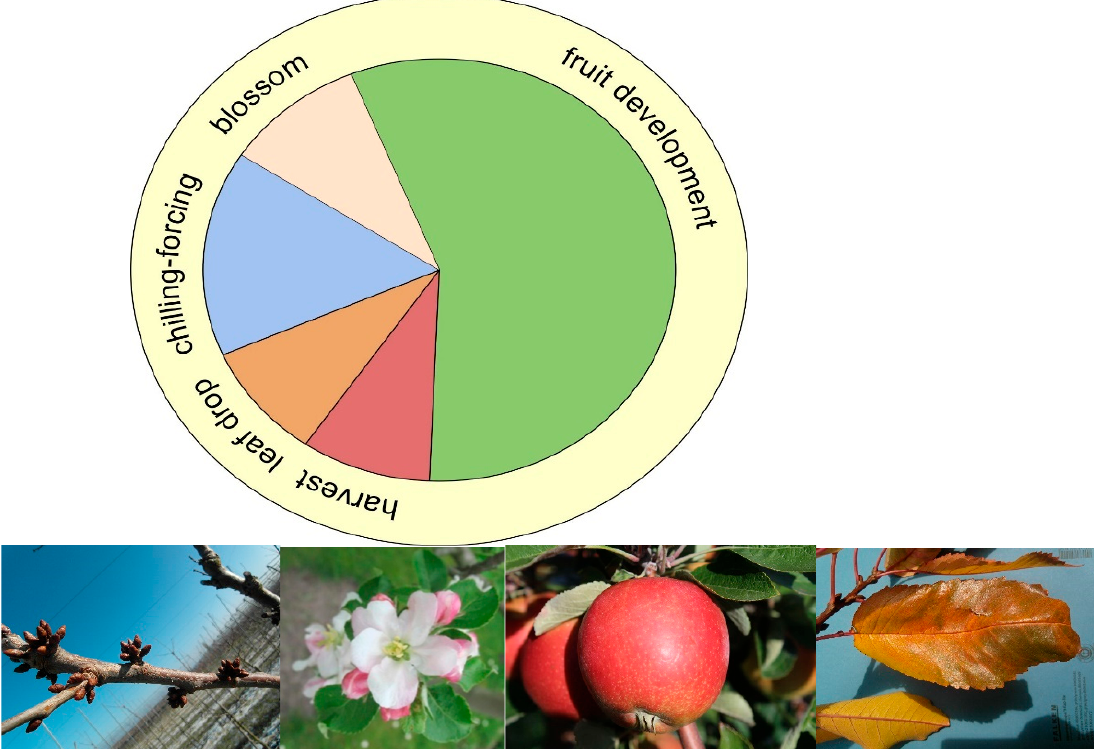
Figure 7. Phenological clock for fruit crops/trees and major climate change effects include an advanced flowering (rose), advanced and extended period of fruit development (flowering to harvest; green), earlier start of chilling and shorter time for chilling and forcing (blue).